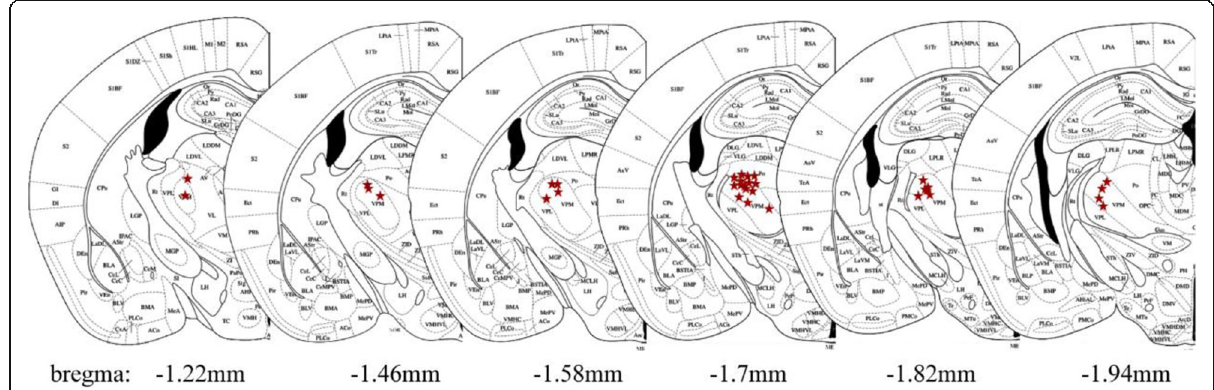
Fig. 2 Locations of all the implanted GRIN lenses. The red star symbols indicated the micro-endoscope insertion point of 34 mice in our experiment, matching the standard mouse brain